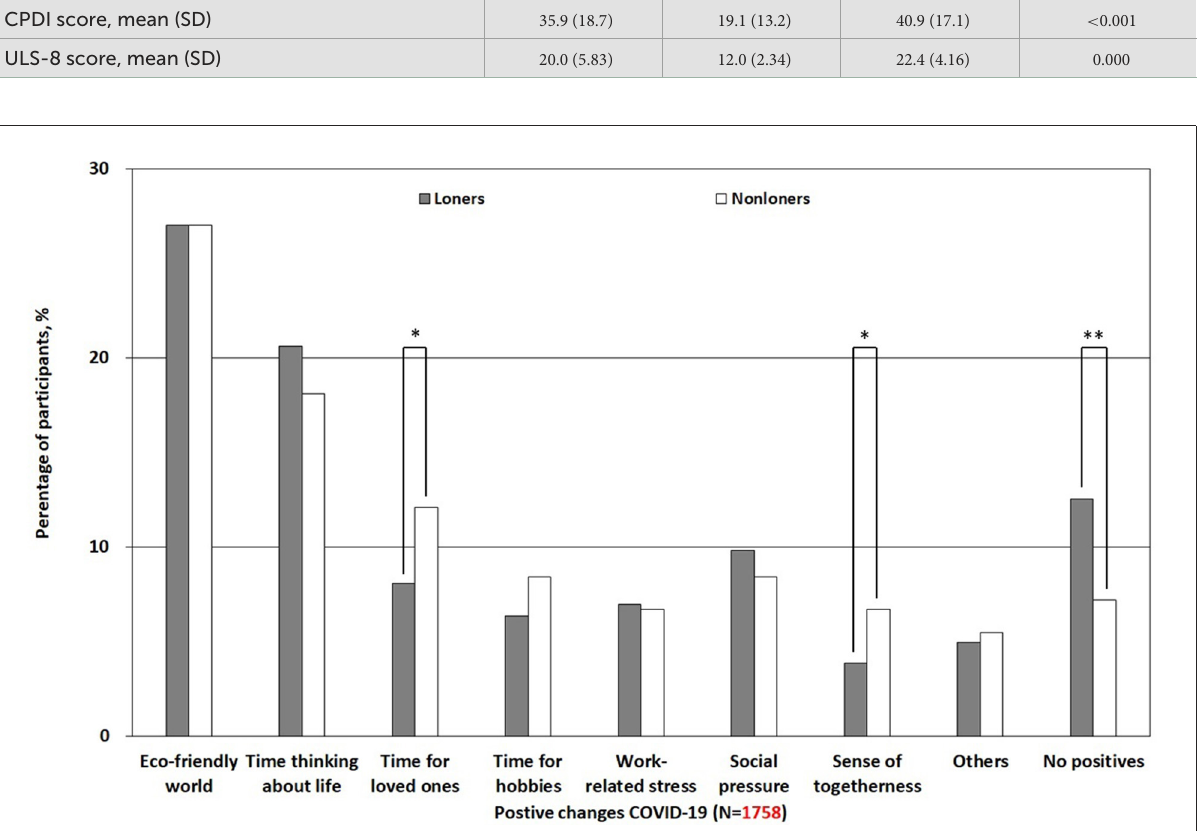
FIGURE1 Differences in positive experiences of living in the COVID-19 pandemic among lonely and non-lonely individuals. * p < 0.05; ** p < 0.01.